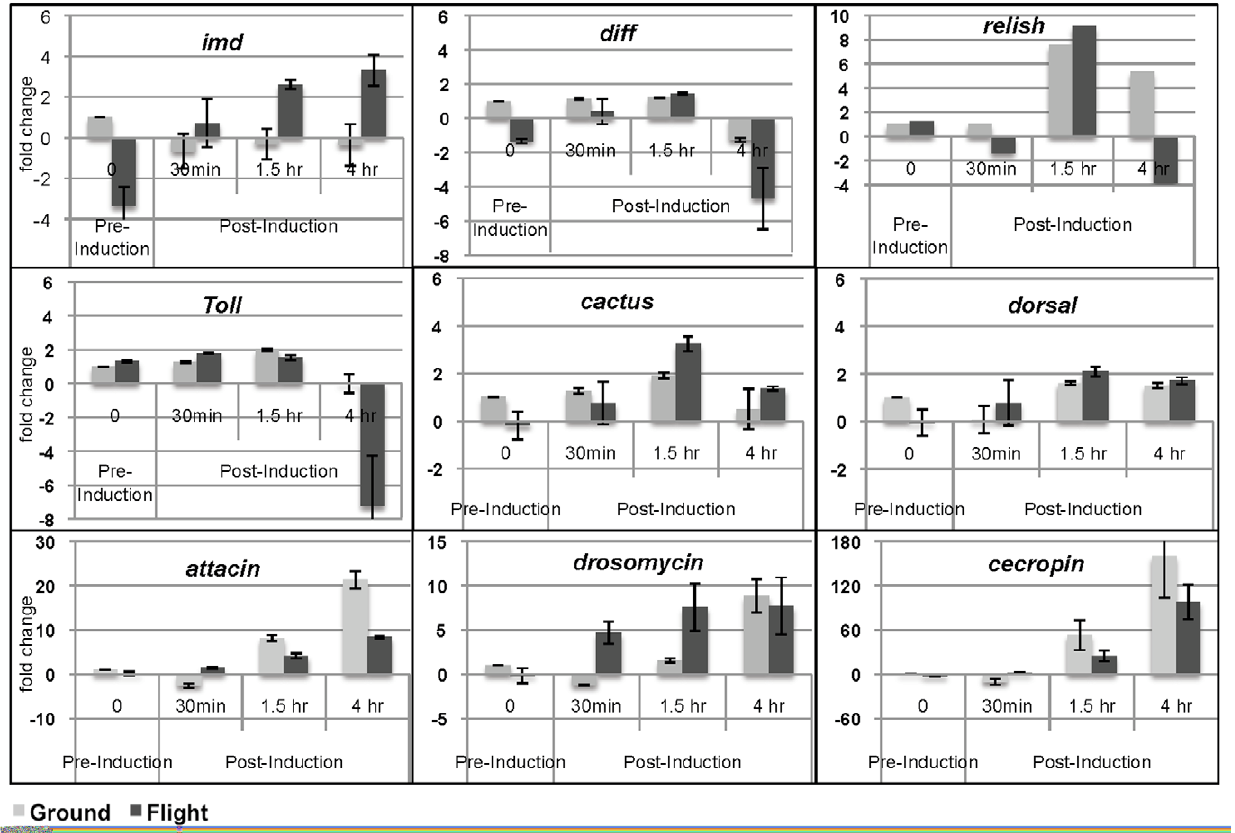
Figure 5. The humoral response to E.coli infection in adults after spaceflight. The time course of gene expression after bacterial infection was compared between flight and ground-reared adult females using qPCR. Data was averaged from two experimental samples, with the exception of relish. Mock- infected flight RNA levels were normalized against ground control to obtain the pre-infection level, and all time course points for ground and flight were normalized against their respective pre-infection level.